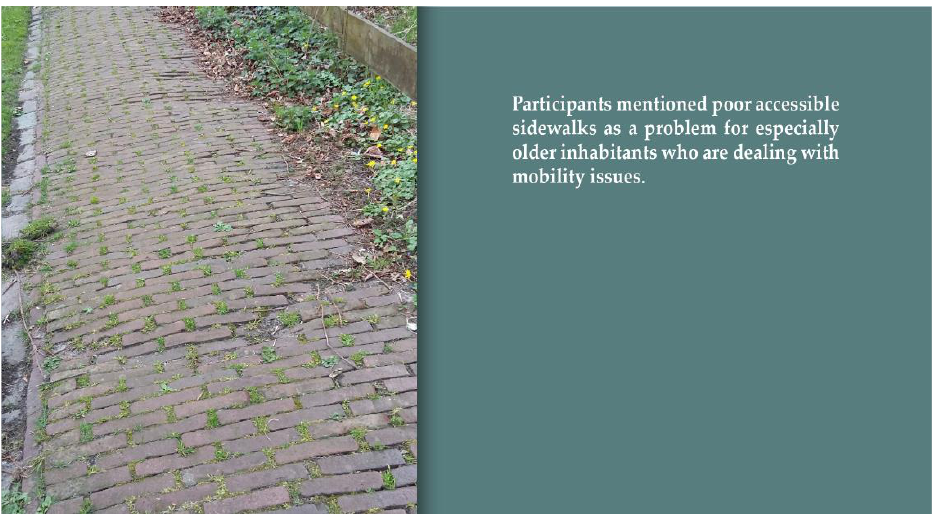
Figure 2. Poor accessible sidewalks. Source: photo submitted by a participant for the photovoice study.